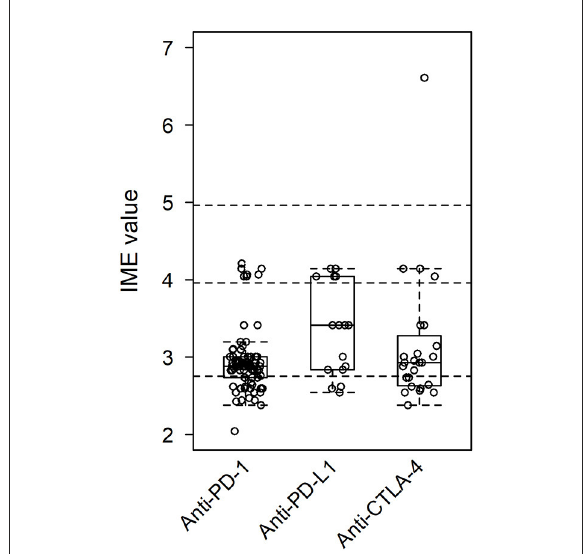
FIGURE5 Integrated metric of evidence (IME) values for class of ICI. The median IME values were 2.88, 3.41, and 2.93 for anti-PD-1, anti-PD-L1, and anti-CTLA-4,